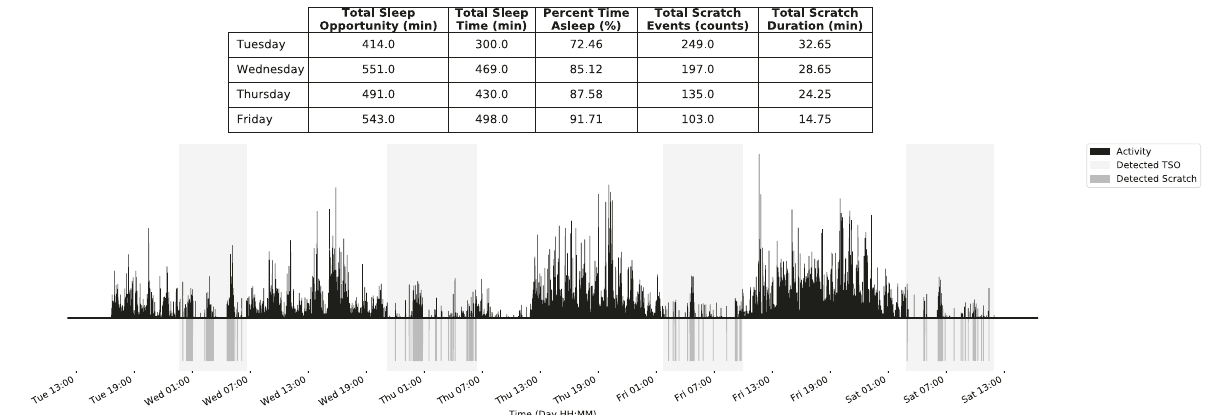
Fig. 2 Continuous detection of sleep and nighttime scratch for a 5-day participant recording. The proposed approach is able to process continuous accelerometer recordings from wearable devices worn on the wrist with no input from the user. The total sleep opportunity (TSO) and subsequent scratch events within the TSO period are dynamically detected and assessed for each night of the